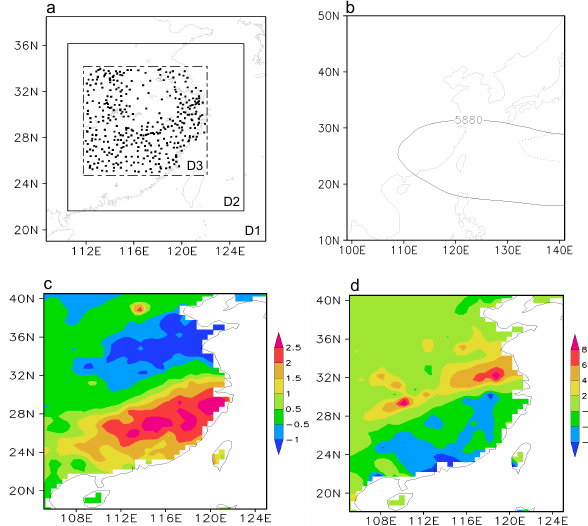
Figure 1. The study areas and climatology. (a) The model domain, where the D1 and D2 sub-areas are the large and nested areas, re- spectively, while D3 is the “core” region of southeastern China, where the extremely high temperatures occurred (the meteorolog- ical stations are marked by dots). (b) The 500hPa 5880gpm con- tours of the climatological averages for July 2003 (solid line) and the base period (1971–2000; dashed line). (c) The July 2003 SAT anomaly, i.e. departures from the base period (1971–2000) average (unit: ◦ C). (d) Same as (c) but for precipitation (units: mmd − 1 ) .